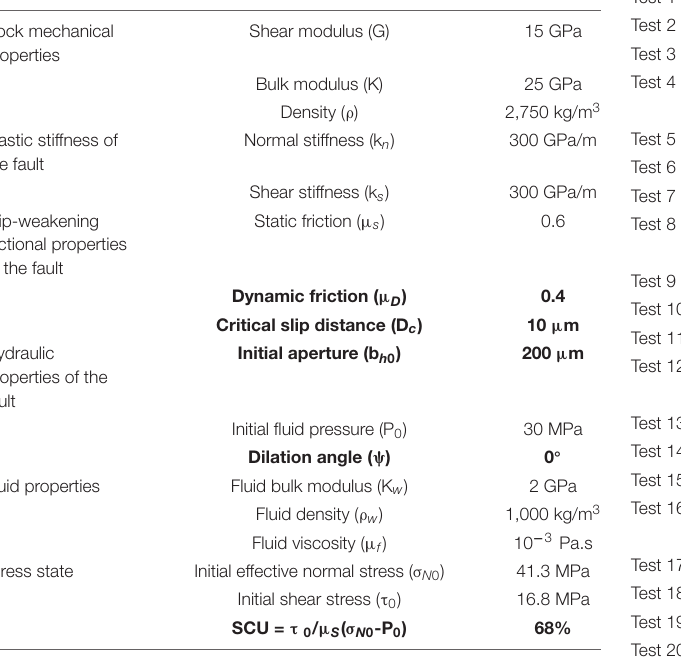
TABLE 1 | Model parameters for the reference case.